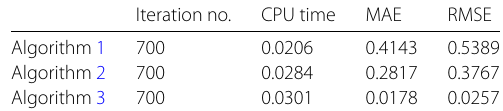
Figure 1 A regression of a sine function at the 700th